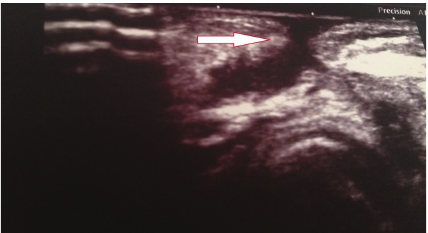
Figure 2: Ultrasonographic image of the subcutaneous sinus